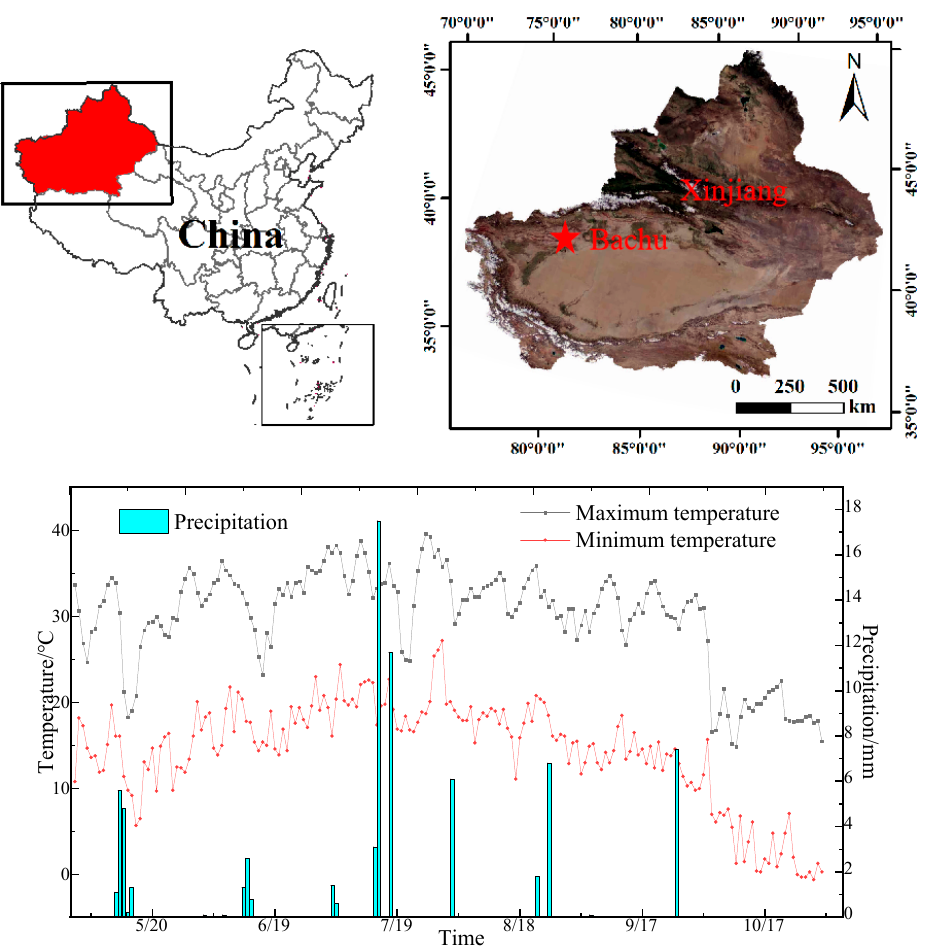
Figure 4. Meteorological data and geographic location of the study area.